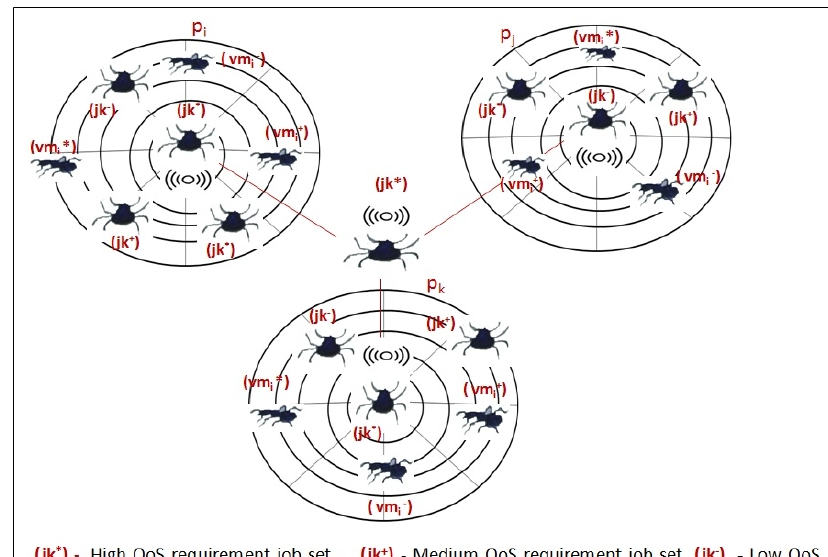
Figure 3: Social interaction behavior of spider load balancing